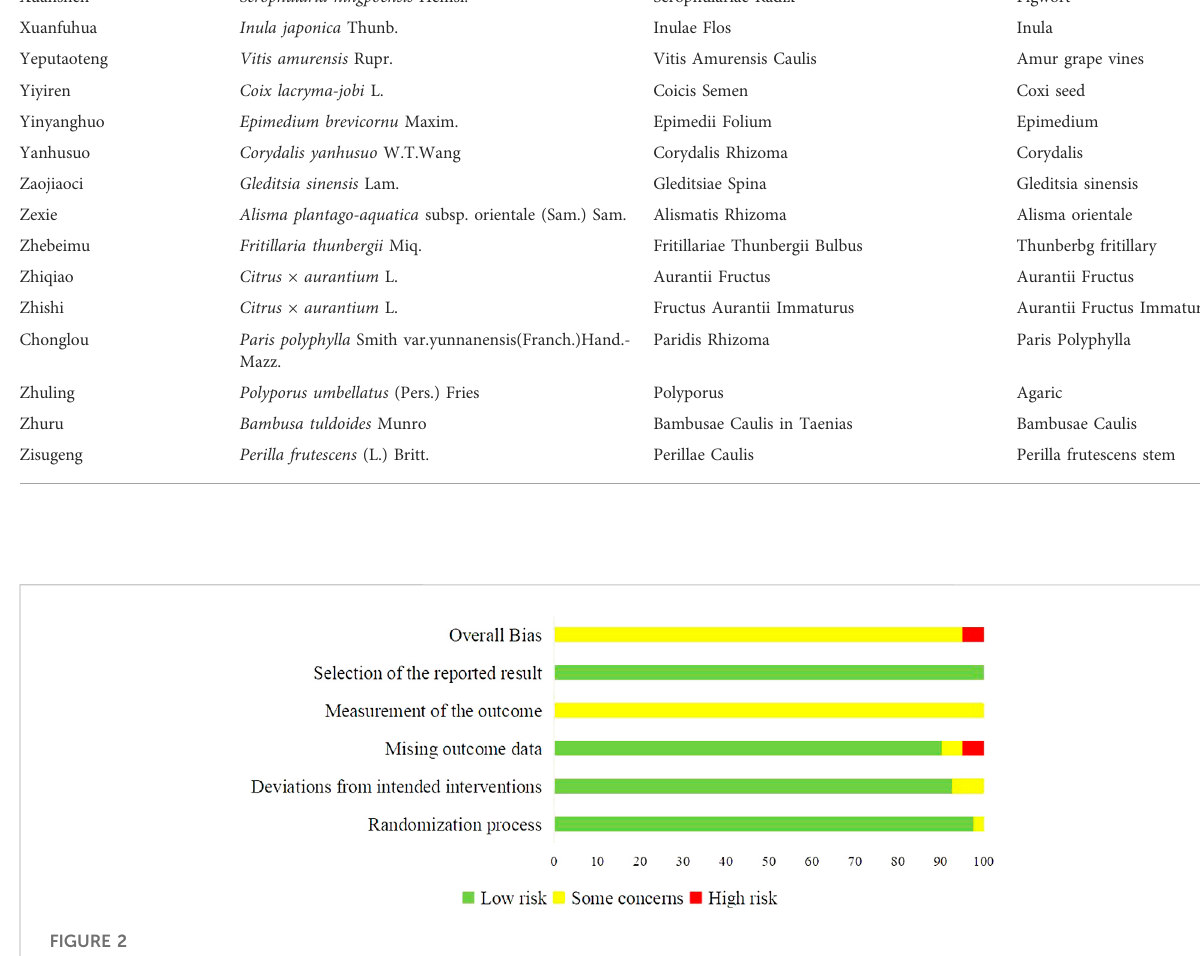
FIGURE 2 Summary of risk of bias of included